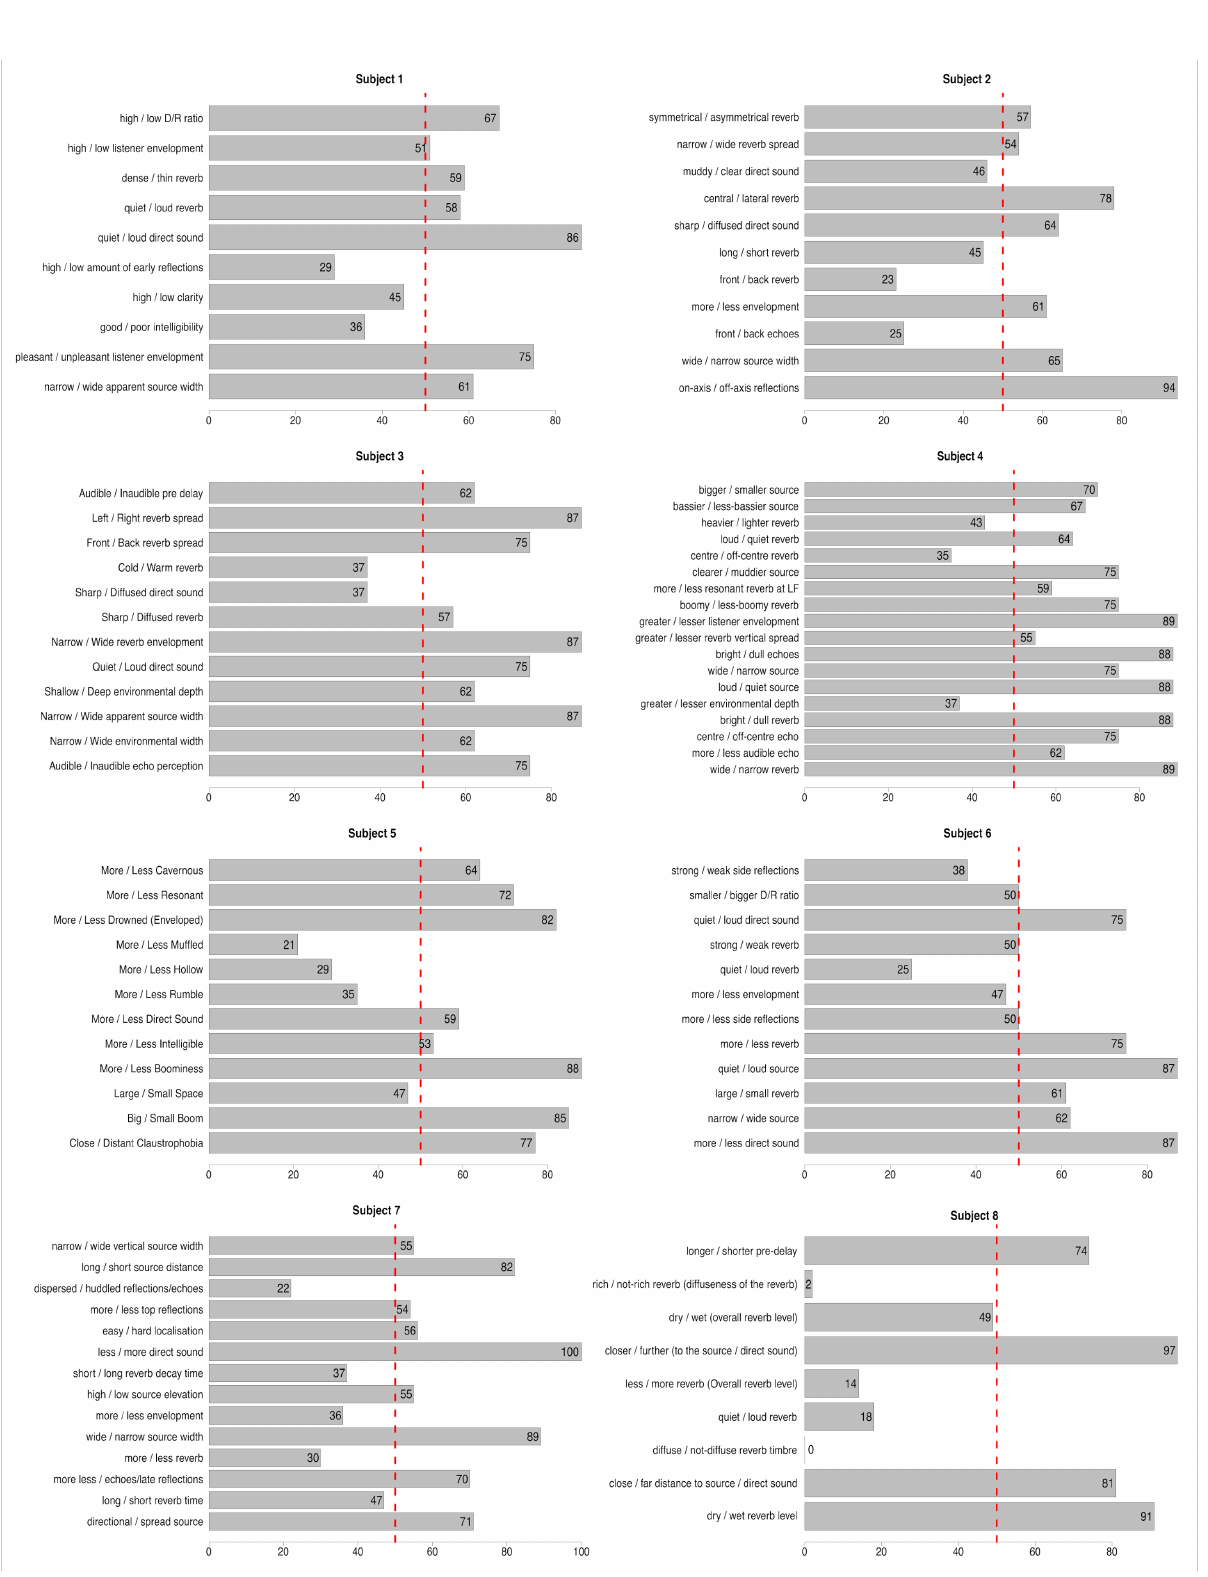
Figure 6. Audibility rating for each